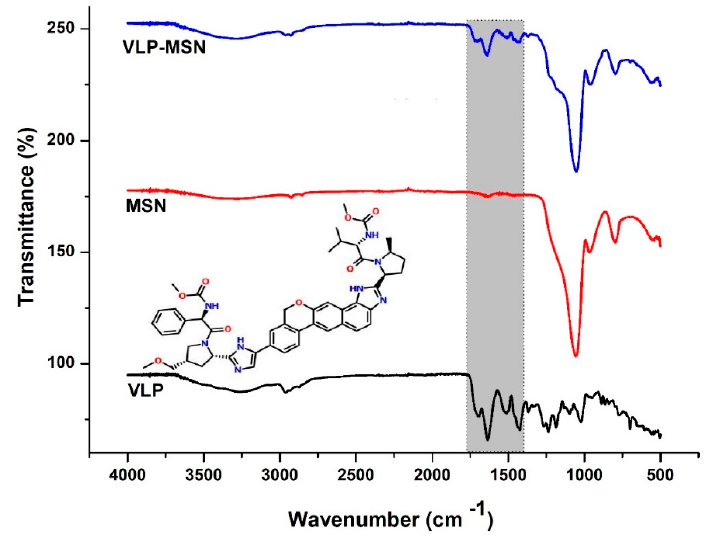
Figure 3. FTIR spectra of MSNs, VLP and VLP-MSNs. Inset picture shows the chemical structure of VLP while the shadowed region shows VLP peaks in pure sample and drug loaded particles.